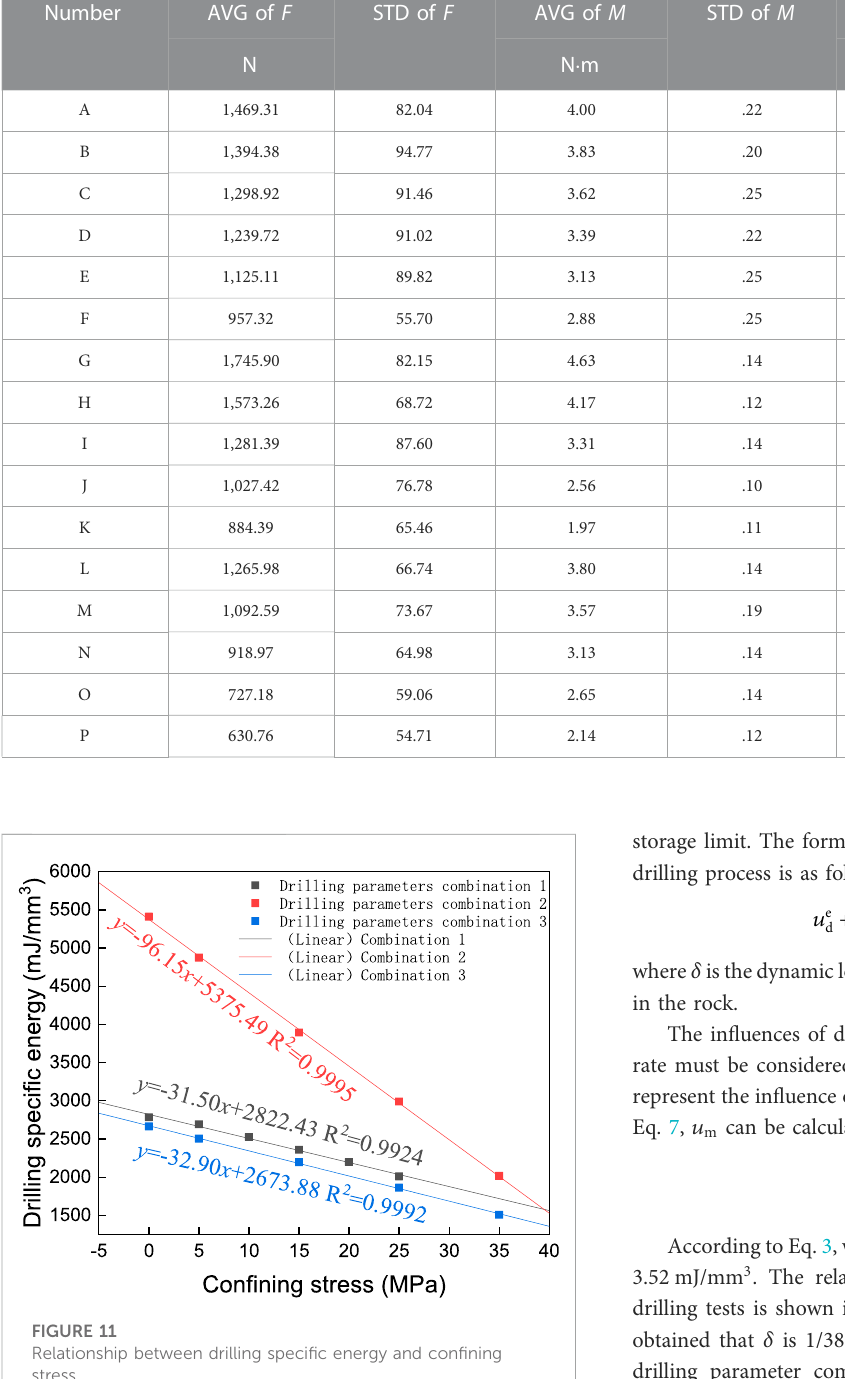
is s in these s